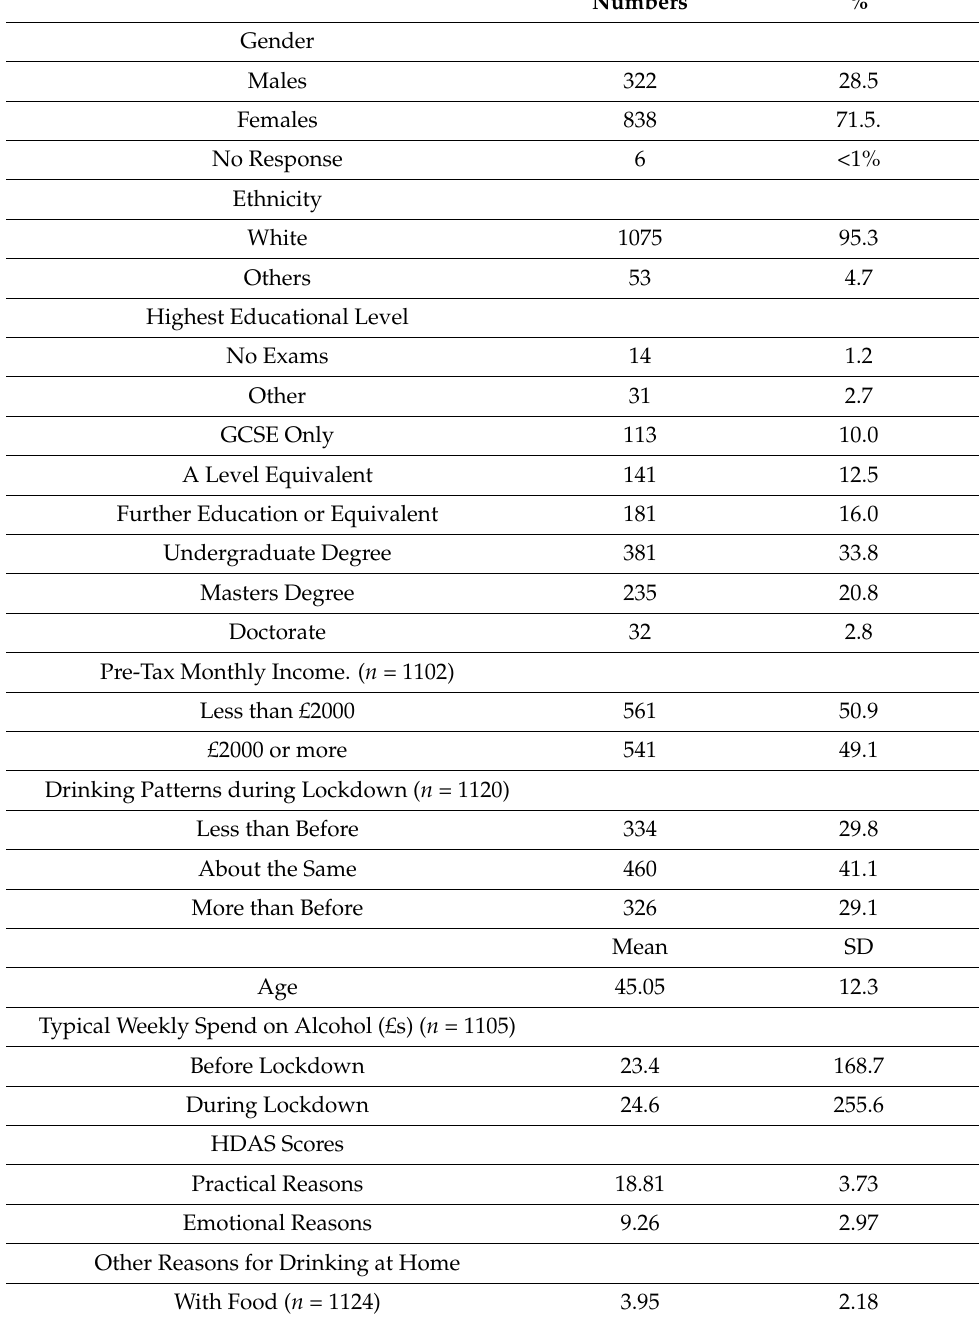
Table 1. Characteristics of the total sample ( n